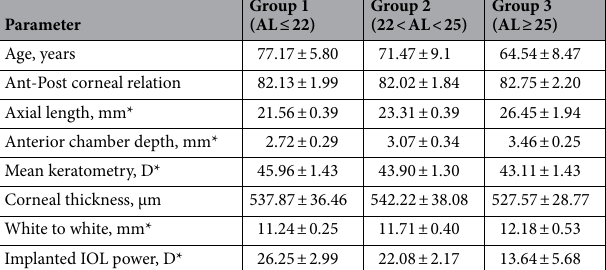
Table 1. Demographic and biometric data of patients by the group. * p < 0.05 statistical significance.